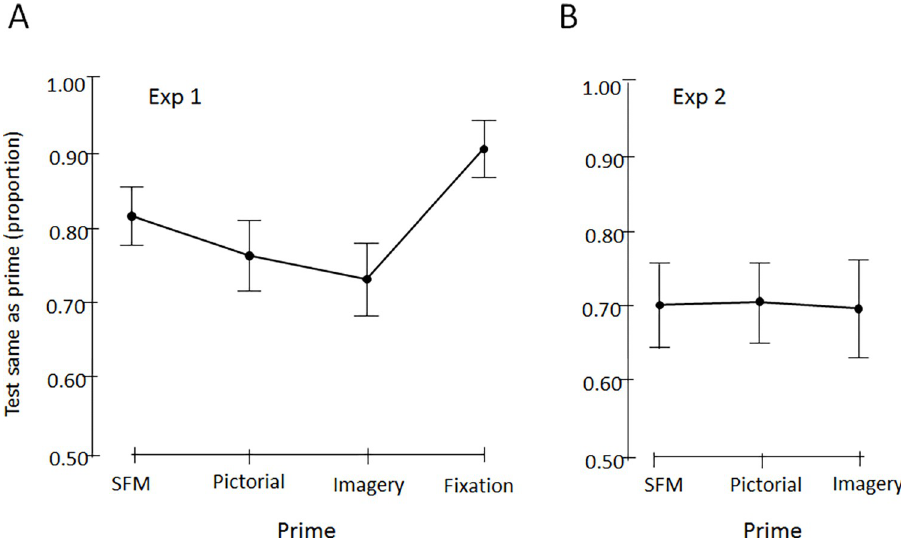
Fig 4. Mean priming. The graphs show the proportion of responses where the orientation of the ambiguous test cylinder was perceived as the same as the prime cylinder. The .5 level indicates no relation between the orientation of the prime and perceived orientation of the test stimulus. (A) The average influence of the primes from Experiment 1 where the prime and test were located at the same place, and a fixation condition where no prime was presented. In the fixation condition, before the cylinder appeared participants were instructed to direct their gaze to a location where one of the ends of the ambiguous cylinder would appear. The proportion indicates occurrences where the gaze direction coincides with the perceived near part of the ambiguous cylinder. (B) In Experiment 2 the test cylinder appeared at a random location around the previously presented prime to prevent influences of cueing to the nearest perceived part of the prime. The 95% CI’s are